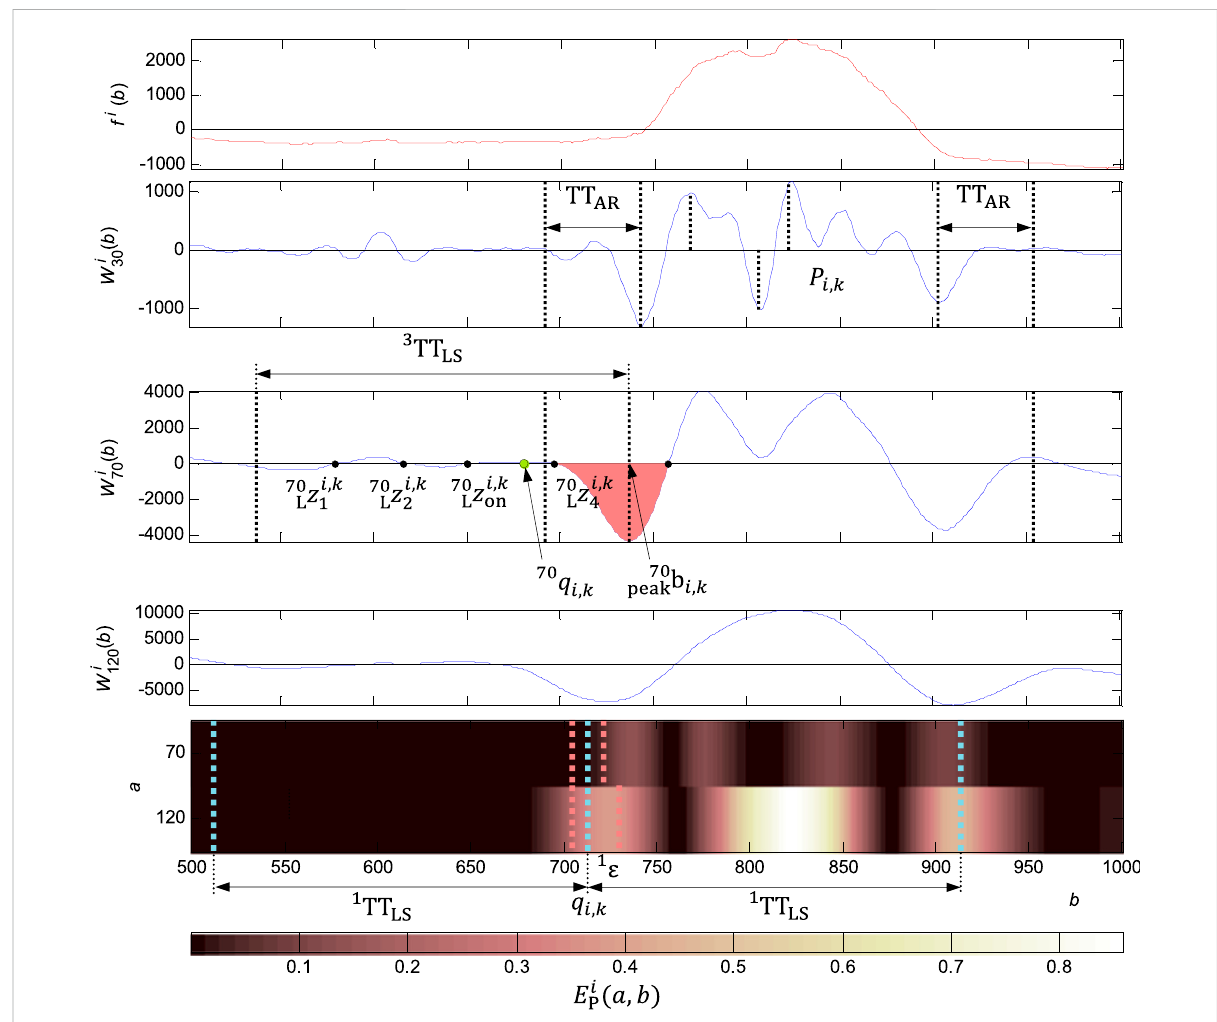
FIGURE 8 Adjusting the QRS onset for a wide QRS. In the fi rst graph from the top: the original signal f i ( b ) (wide QRS). In the second graph from the top: ( b ) withthesetof P i , k pointsfoundanddelimitedbytheTT W i 30 in the range of 3 TT LS , the time interval of the zero point 70 L z i , k 4 is coloured by red, where 70 logic i , k 4 (cid:2) 1, the new zero point 70 L z i , k on (cid:2) 70 L z i , k 3 found and the QRSonset 70 q i , k .Inthefourthgraphfromthetop: W i 120 ( b ) forcomparisontoscalogram.Inthe fi fthgraphfromthetop: E i P ( 70 , b ) and E i P ( 120 , b ) and maximum energy MAX E i , k (cid:4) 0 , 81 in the range of 1 TT LS , the q i , k neighbourhood coloured by red is the zone for the high energy detection by the de fi ned condition. In the 1 ε neighbourhood there were not any thresholds for E i , k ( a , b ) exceeded, however, at the scale 120 there was the double energy related to the scale 70 in the range de fi ned by 1 TT LS . On condition for the wide QRS was met and the QRS was quali fi ed as